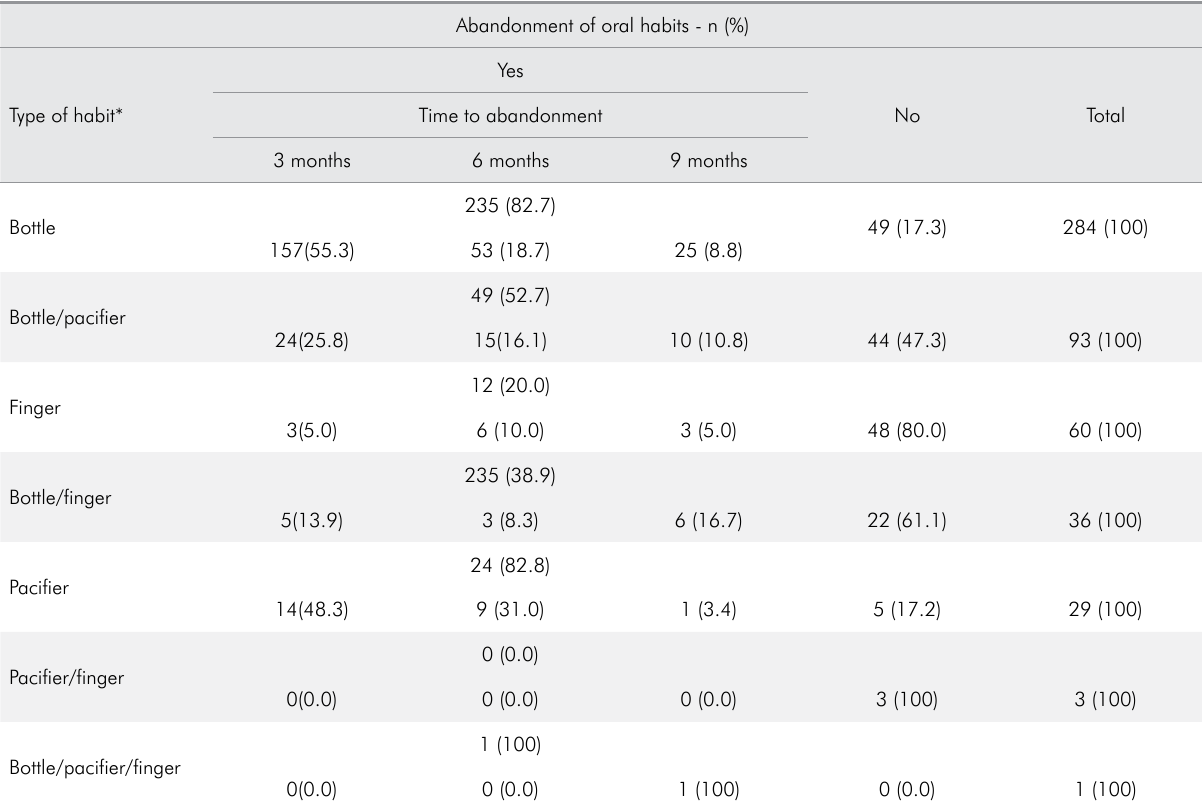
Table 2. Distribution of the type of oral habits in relation to the time to abandonment. Abandonment of oral habits - n (%)